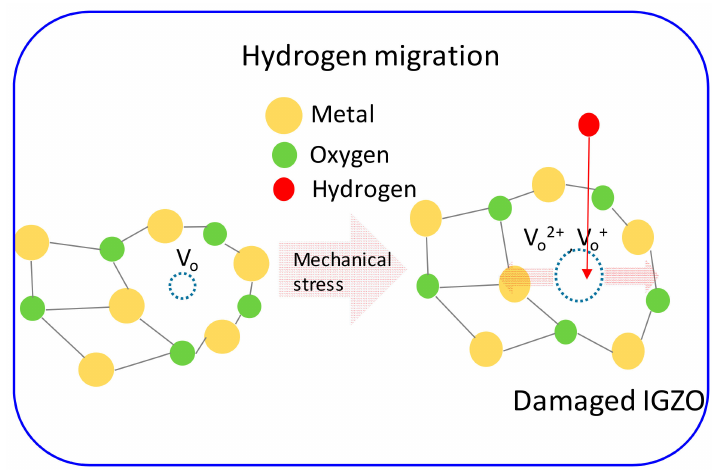
Figure 7. Schematic diagram illustrating the physical mechanism responsible for more enhanced hydrogen di ff usion form atomic layer deposition (ALD) Al 2 O 3 gate dielectric into an IGZO layer in IGZO TFTs under mechanical bending